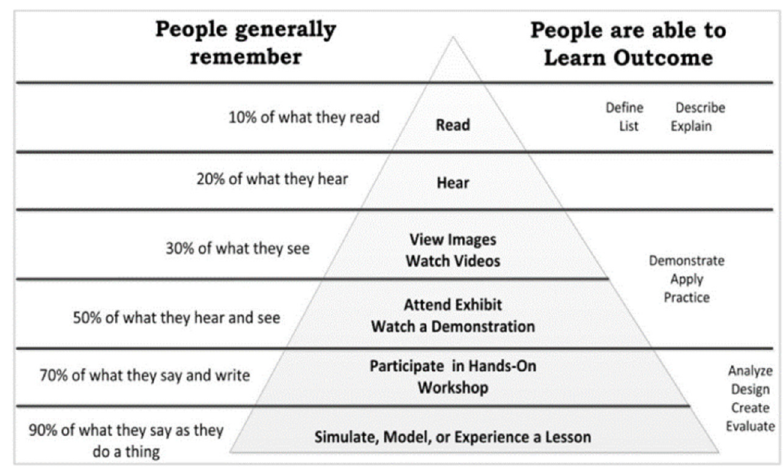
Figure 8. Edgar Dale Cone of Experience (Dale,